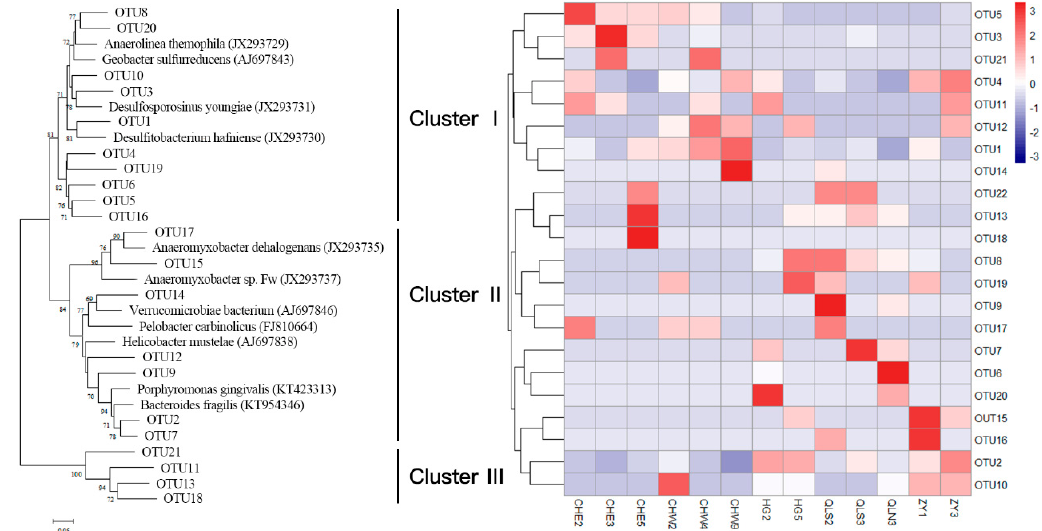
Figure 5. Neighbor-joining phylogenetic tree of nrfA sequences and heatmap showing clustering among different lakes based on operational taxonomic units’ (OTUs) relative abundance.